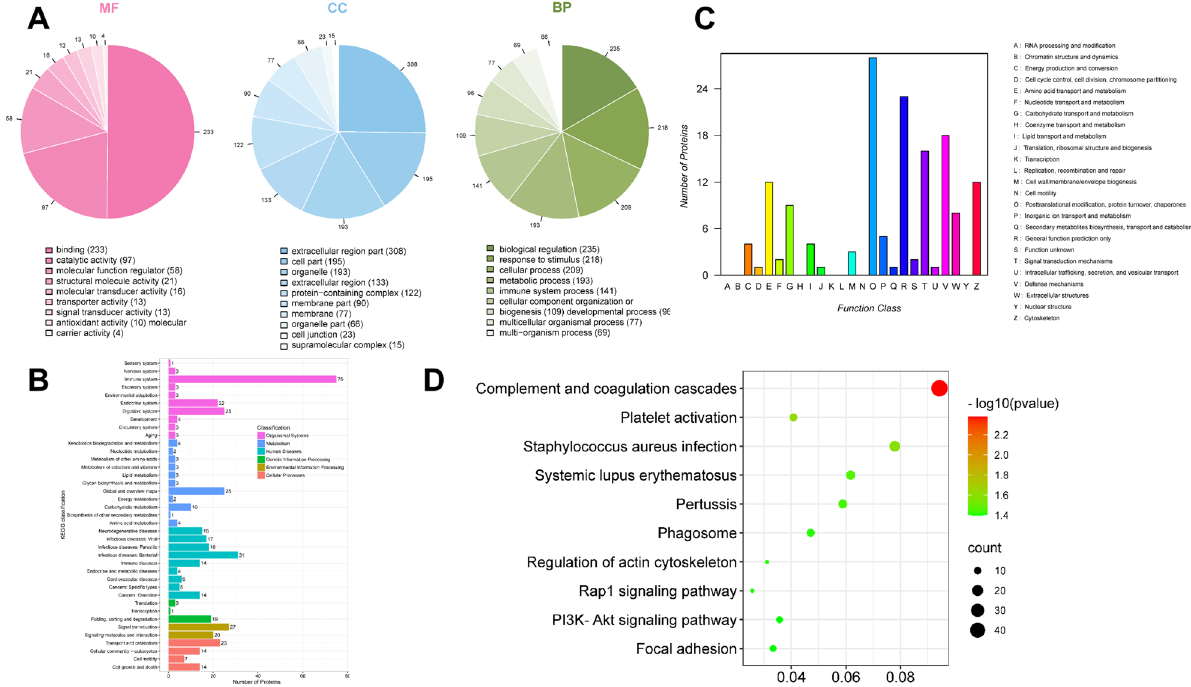
Figure 4. Quantitative bioinformatic analyses of a rat model of CMS. ( A ) GO functional annotation analysis of proteins identified by iTRAQ and categorized by biological process, molecular function, and cellular component, in the MG group as compared against the CG and DML·H groups. ( B ) KEGG pathway analysis of the proteins identified by iTRAQ. ( C ) COG function classification of the proteins identified by iTRAQ. ( D )The top 20 pathways with the largest number of